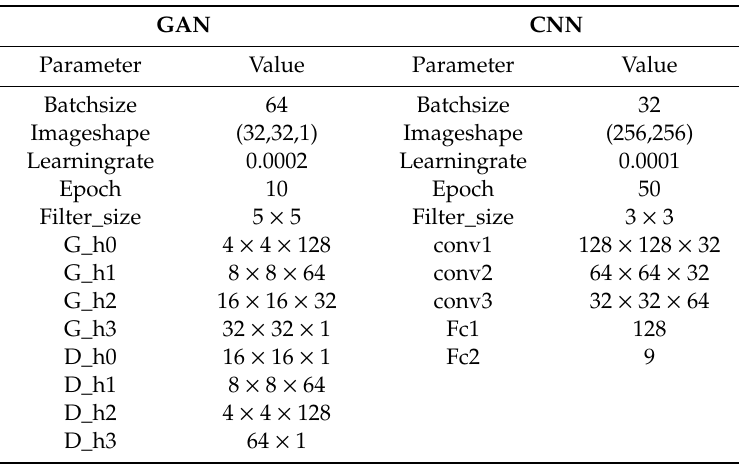
Table 2. Parameters and values used in the